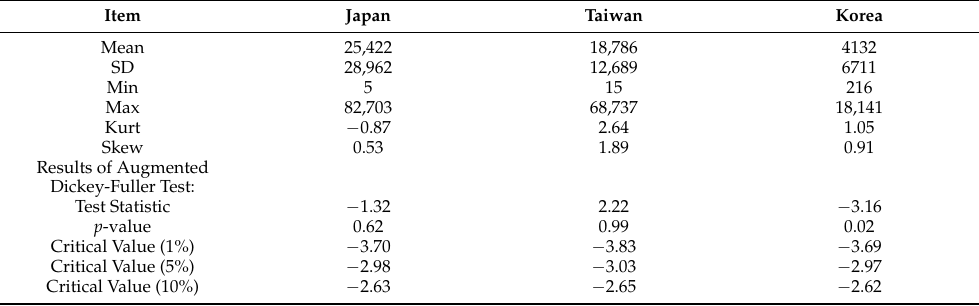
Figure 2. The heatmap of annual labor exports to Japan, Taiwan, and Korea. The expected statistical results as the Mean, Min, and Max values, St Dev, Skew, and Kurt are also pointed out in Table 1 to quantitatively analyze the yearly labor export char- acteristics to interpret their significance further. The mean is the crucial popular measure of central trend, and the indicator may be used with continuous data. The Minimum and Maximum values indicate the margin of the time series. The Standard Deviation is used to measure the degree of data dispersion. Finally, Skewness and Kurtosis are deployed to estimate whether the distribution of the sample is normal or not. The statistics result in Table 1 indicate as below: The Mean and Standard Deviation of the labor exports to North- East Asian countries were 25,422 persons and 28,962 persons in Japan, 18,786 persons and 12,689 persons in Taiwan, 4132 persons and 6711 persons in Korea, respectively. The skewness for a normal distribution is zero, and any symmetric data should have a skew- ness near zero. Negative values for the skewness indicate skewed left data, and positive values for the skewness indicate skewed right data [33,34]. Skewness coefficients were low for the data sets. This approach is appropriate for modeling because a high skewness coefficient has a considerable negative effect on ANN performance [35]. Hence, the values of Kurt and Skew of the data fluctuating from −8 .87 to 2.64 could be accepted for predic- tion through these models. The labor exports to the region using Augmented Dickey- Fuller (ADF) test also point out that the database is separated two parts such as the data of labor exports to Korea ( p -value = 0.02, test statistic = −3 .16) has a unit root, this data is stationary, and the data of labor exports to Japan ( p -value = 0.62, test statistic = −1 .32) and Taiwan ( p -value = 0.99, Test Statistic = 2.22) do not have a unit root, these data are non- stationary. Furthermore, the time series data are stationary; they can be easily modeled with higher accuracy than their non-stationary counterparts [36]. The input data patterns of the three nations were randomly selected with two sec- tions. The first section was used for the training phase, and it contained roughly 70% of the total data. The remaining 30% of the labor export data was contained in the second component, which was used for the test phase. Table 1. Descriptive statistics and formal hypothesis test of labor exports to Northeast Asian Countries from 1992 to